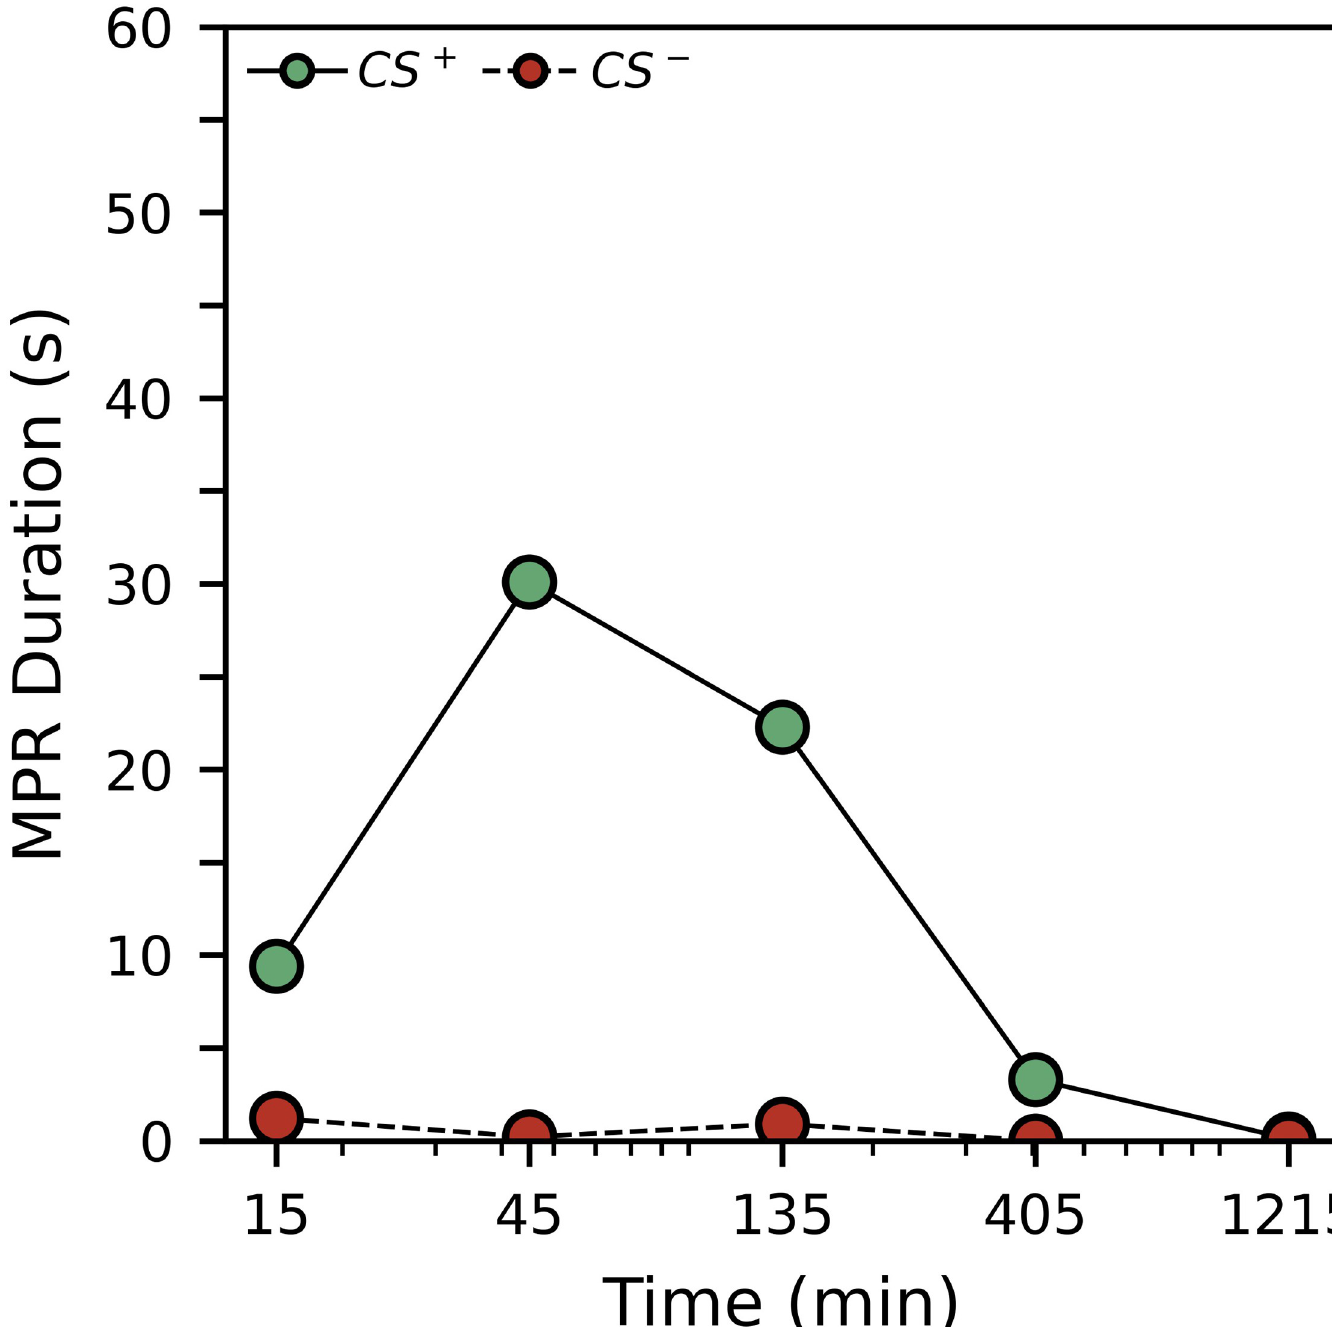
Fig 5. Experiment 2 average MPR duration in response to the CS + and CS - during the preference